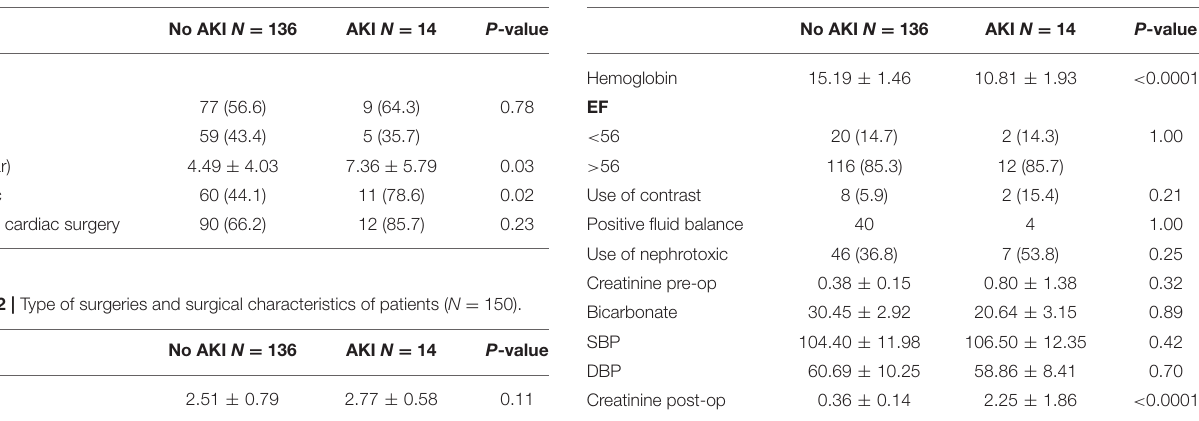
TABLE 3 | Clinical and biochemical data of patients ( N =